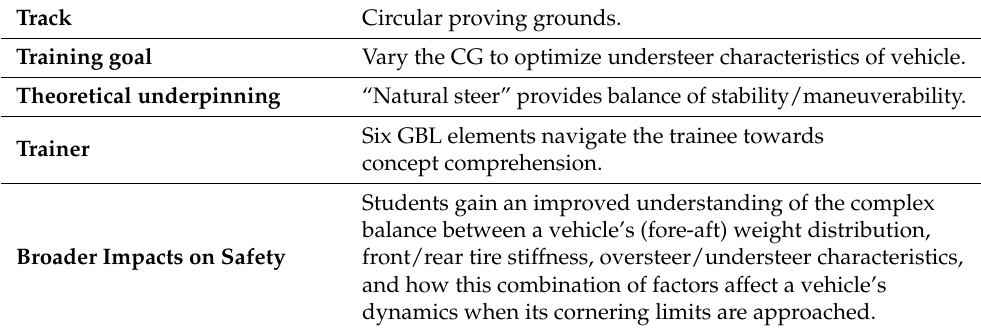
Figure 6. GBL skid pad implementation (with embedded gaming elements). Table 1. Skid pad (experiment